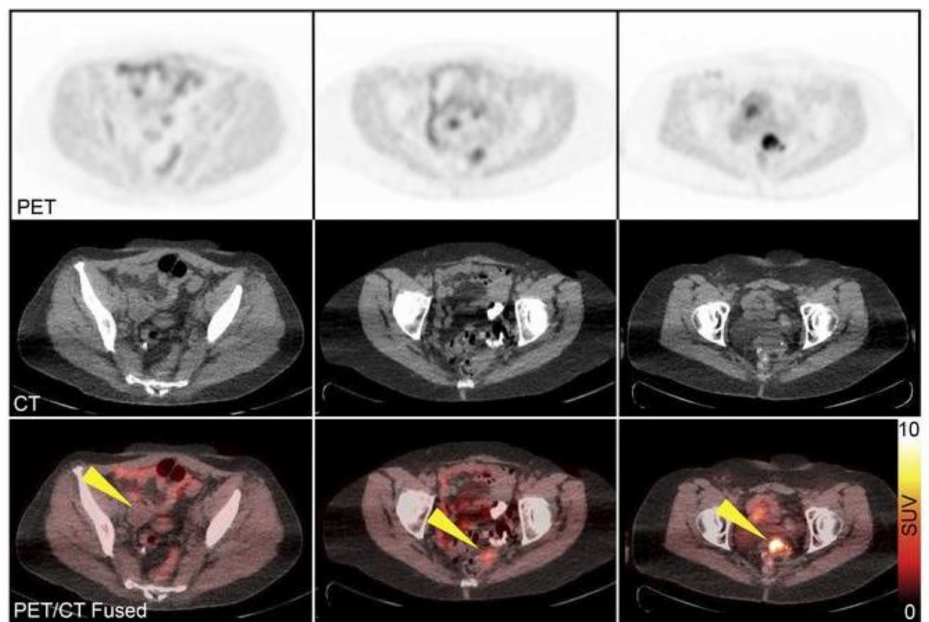
Figure 2. PET / CT images of 18 F-FTT uptake in ovarian cancer patients. PET / CT images from a clinical trial (NCT02637934) in three ovarian cancer patients show a wide range of 18 F-FTT uptake in tumor lesions. Standard uptake value (SUV) ranges from 2 (top-left) to 12 (top-right). Yellow arrows indicate sites of tumor. Reproduced with permission from Makvandi et al., titled “A PET imaging agent to evaluate PARP expression in ovarian cancer”, published by The Journal of Clinical Investigation, 2018